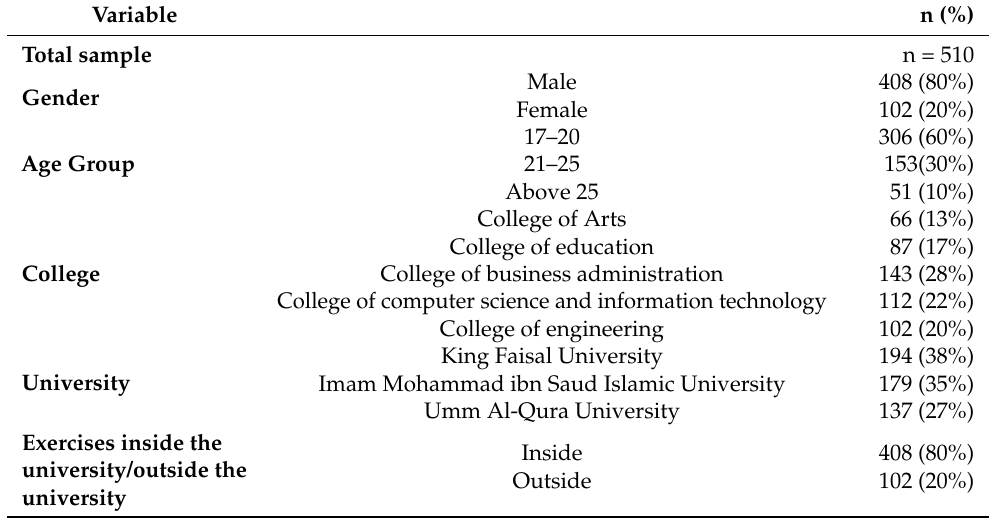
Table 1. Demographic and Descriptive